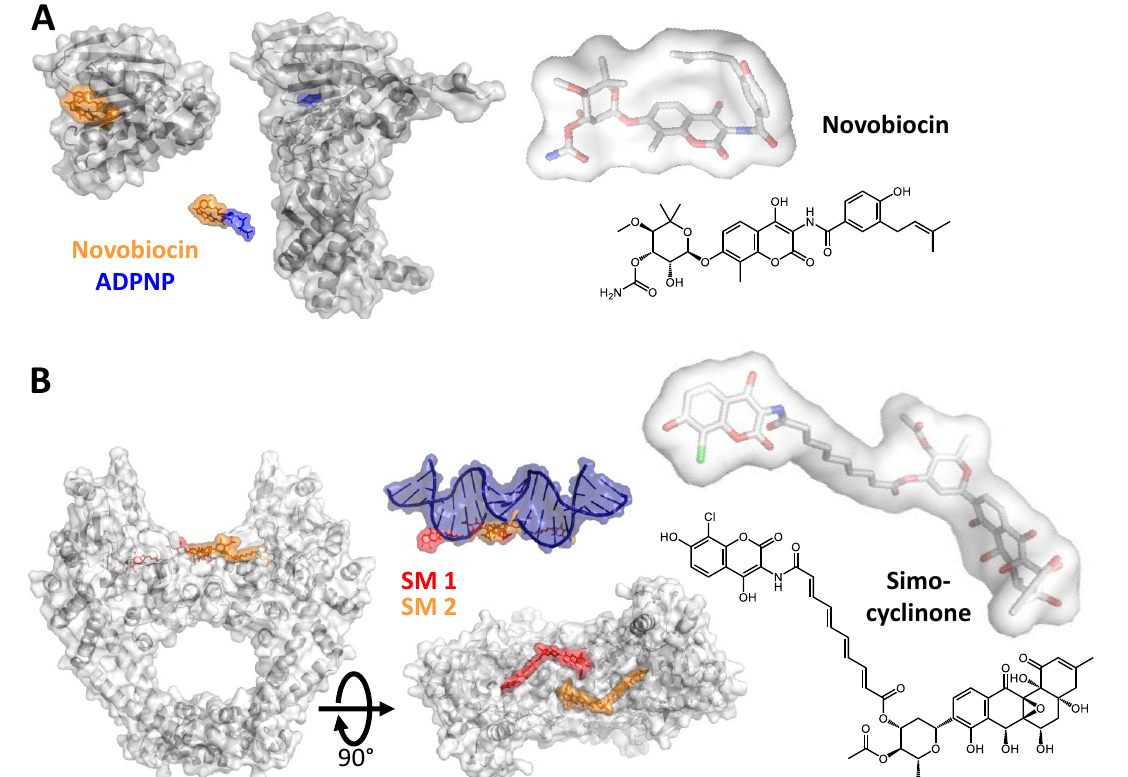
Figure 2. Competitive inhibition. ( A ) Left: Structures of the 24 kDa ATPase fragment of Gyr B with Novobiocin bound [48] and of a 43 kDa fragment bound to ADPNP [49]. Novobiocin (orange) binds to the GHKL domain of the GyrB subunit and acts as a competitive inhibitor by blocking the ATP binding site (occupied by ADPNP, blue). Right: Structure of Novobiocin in stick representation (top) and chemical formula (bottom). PDB-IDs: 4uro (24 kDa fragment of Staphylococcus aureus GyrB with Novobiocin), 3zkb (43 kDa fragment of Mycobacterium tuberculosis GyrB with ADPNP). ( B ) Left: Structure of the GyrA NTD with two Simocyclinone molecules bound at the DNA-gate of GyrA (red, orange) [44]. The top view (bottom) shows how the compounds block the DNA binding site. The superposition with the DNA (as bound to GyrA in 2xct, top, ref. [50]) shows the overlapping binding sites. SM 1 and SM 2 are the two inhibitor molecules bound to the GyrA dimer. Right: Structure of Simocyclinone in stick representation (top) and chemical formula (bottom). PDB-IDs: 4ckl ( Escherichia coli GyrA NTD with Simocyclinone), 2xct ( S. aureus GyrBA fragment comprising the GyrA NTD and the GyrB TOPRIM domain, in complex with DNA and Ciprofloxacin).